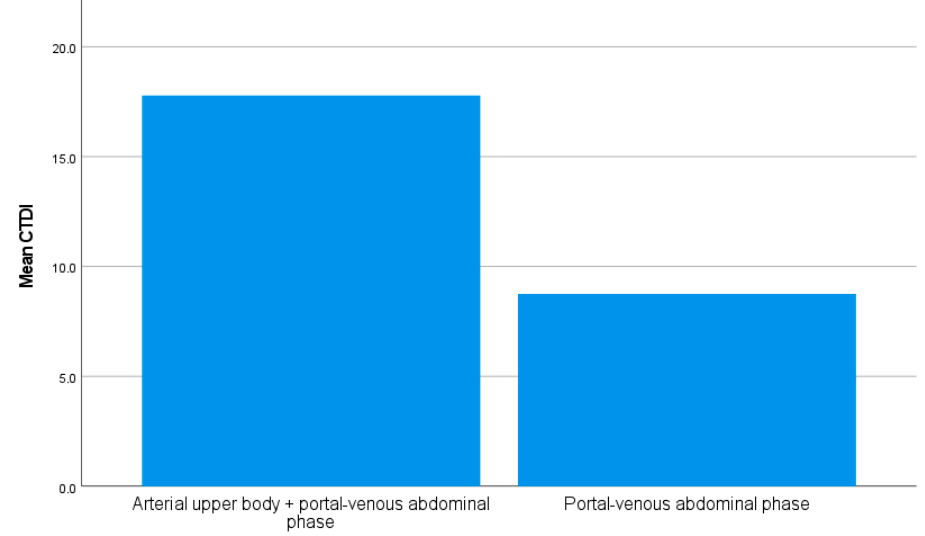
Figure 3. The mean computed tomography dose index (CTDI) can be reduced by 51% if the arterial